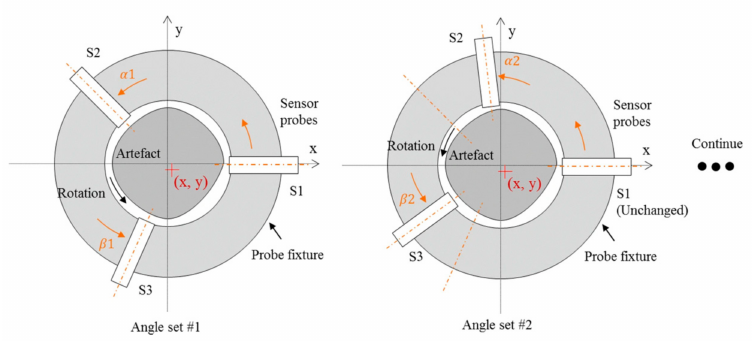
Figure 52. Schematic diagram of the complementary multi-probe error separation method